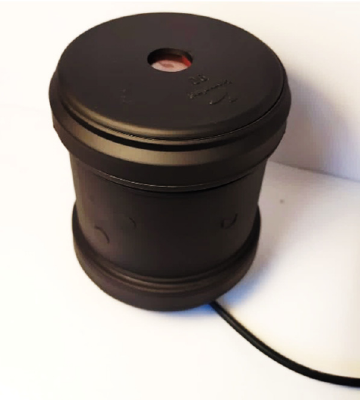
Figure 3. Photograph of the fabricated device.